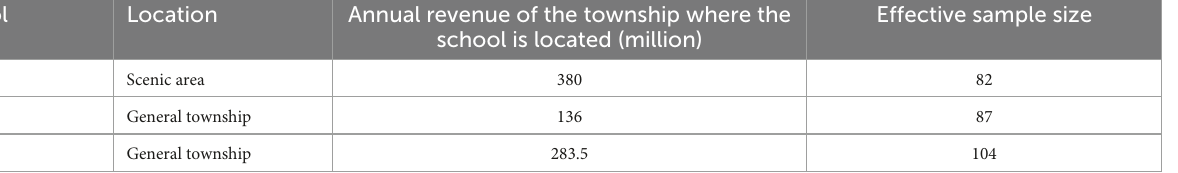
TABLE 1 Sample selection.